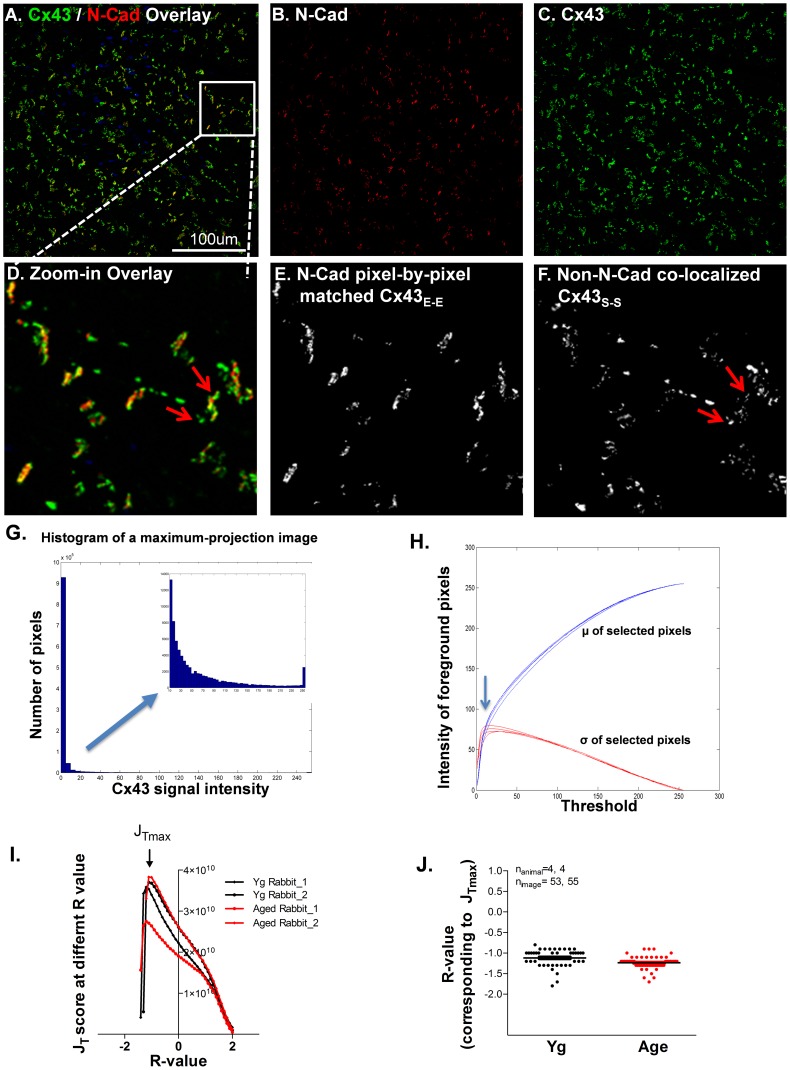
Confocal images of double immunofluorescence staining with Cx43 (green) and N-Cadherin (N-Cad; red) antibodies in rabbit left atrium (LA).
A-C. Representative confocal images of Cx43/N-Cad overlay (A), N-Cad (red; B) and Cx43 (green; C). D-F. Enlarged images from a cropped area of image A including the overlay image (D), N-Cad pixel-by-pixel matched Cx43 (E), and N-Cad non-pixel-by-pixel Cx43 (F). Arrows indicate stellate Cx43 pixels that are in close proximity with the N-Cad pixel but do not co-localize with N-Cad pixel-by-pixel. G. Representative histogram of quantified pixel intensity of Cx43 stained image. H. Representative plot for the mean intensity (blue curve) and standard deviation (red curve) of foreground pixels at different thresholds. I. Representative plot of JT scores corresponding to R-value of four images from two young and two aged rabbit LA. J. Data plot of maximum JT scores of the images from four young and four aged rabbit LA.